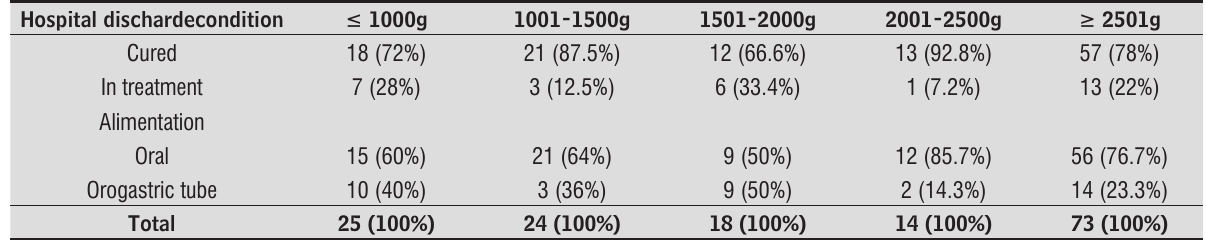
Table 4 - Hospital discharge condition according to birth weight (g) Hospital